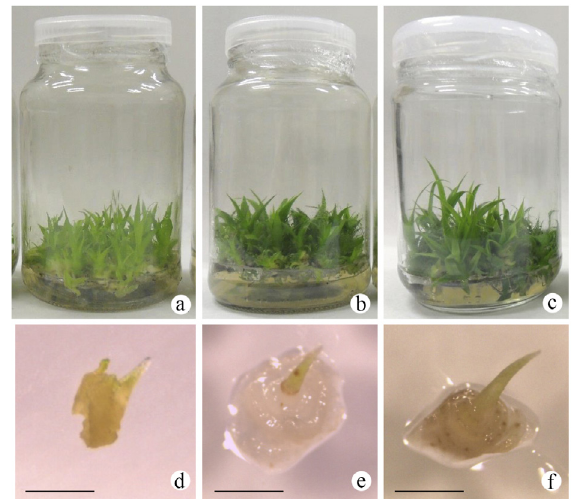
Figure 1. a-b) Plants grown in vitro of Ananas comosus var. parguazensis (BGA-376). d-f) Shoot tips of the same accession cultured for 30 (a, d) 45 (b, e) and 60 days (c, f) after multiplication in culture medium. Bar: 0.5